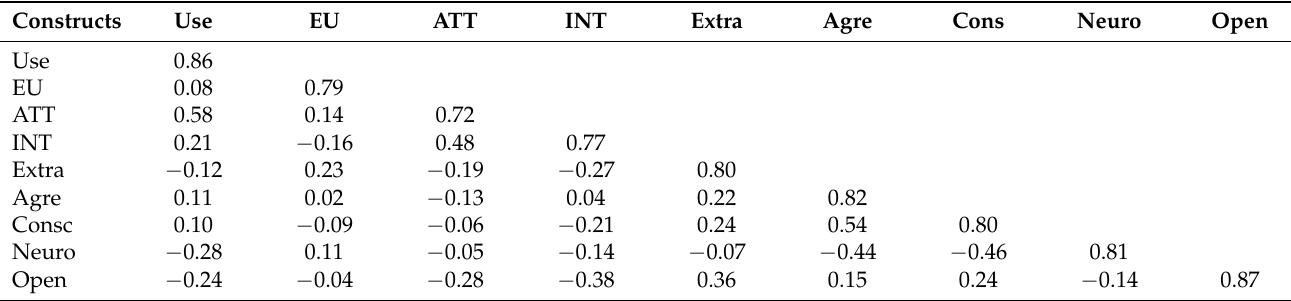
Table 4. Discriminant validity.